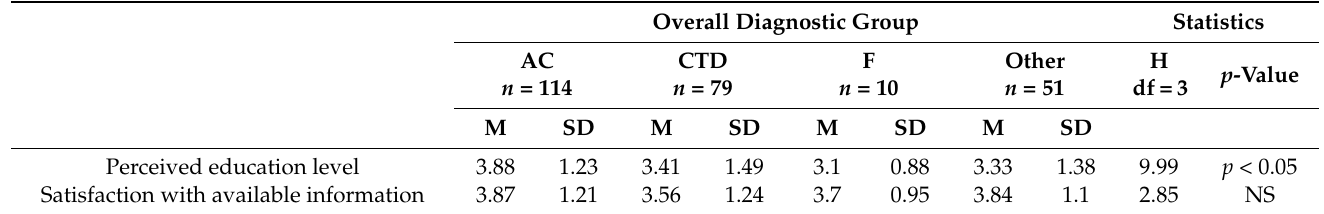
Table 4. Perceived education level and satisfactions with available information by diagnostic group. Overall Diagnostic Group Statistics